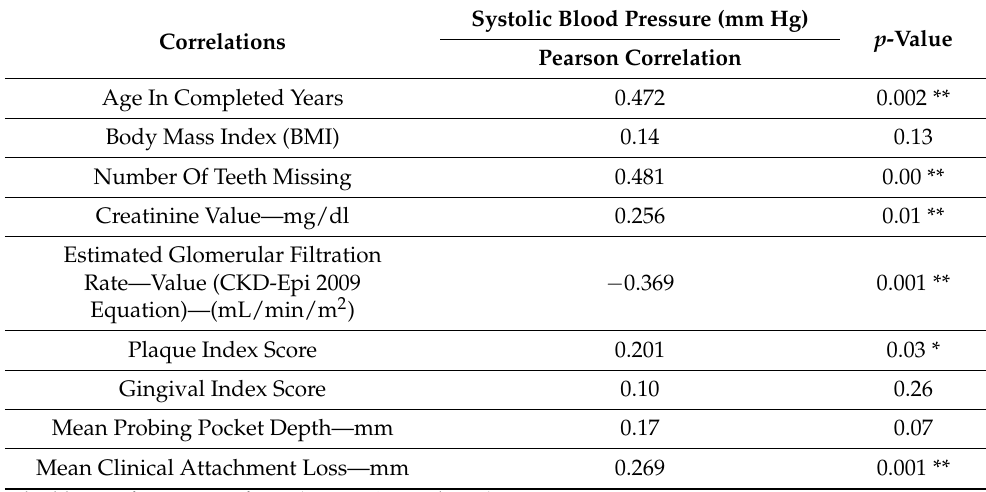
Table 7. Overall Pearson’s correlation of SBP with demographic, periodontal, and renal parameters.